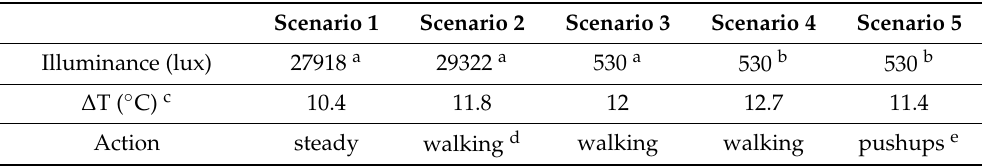
Table 2. Table reporting the five operational conditions used to test the multisource energy harvesting system integrated into the smart garment. Scenario 1 Scenario 2 Scenario 3 Scenario 4 Scenario 5 Illuminance (lux) 27918 a 29322 a 530